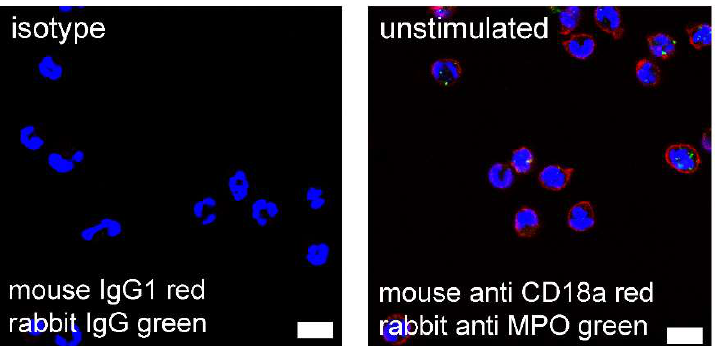
Figure A5. Representative immunofluorescence image (overlay) of anti-CD18a attachment at the surface of neutrophils. Settings of the microscope were adjusted based on the presented isotype control (scale bar = 10 µm; blue = DNA, myeloperoxidase = MPO).